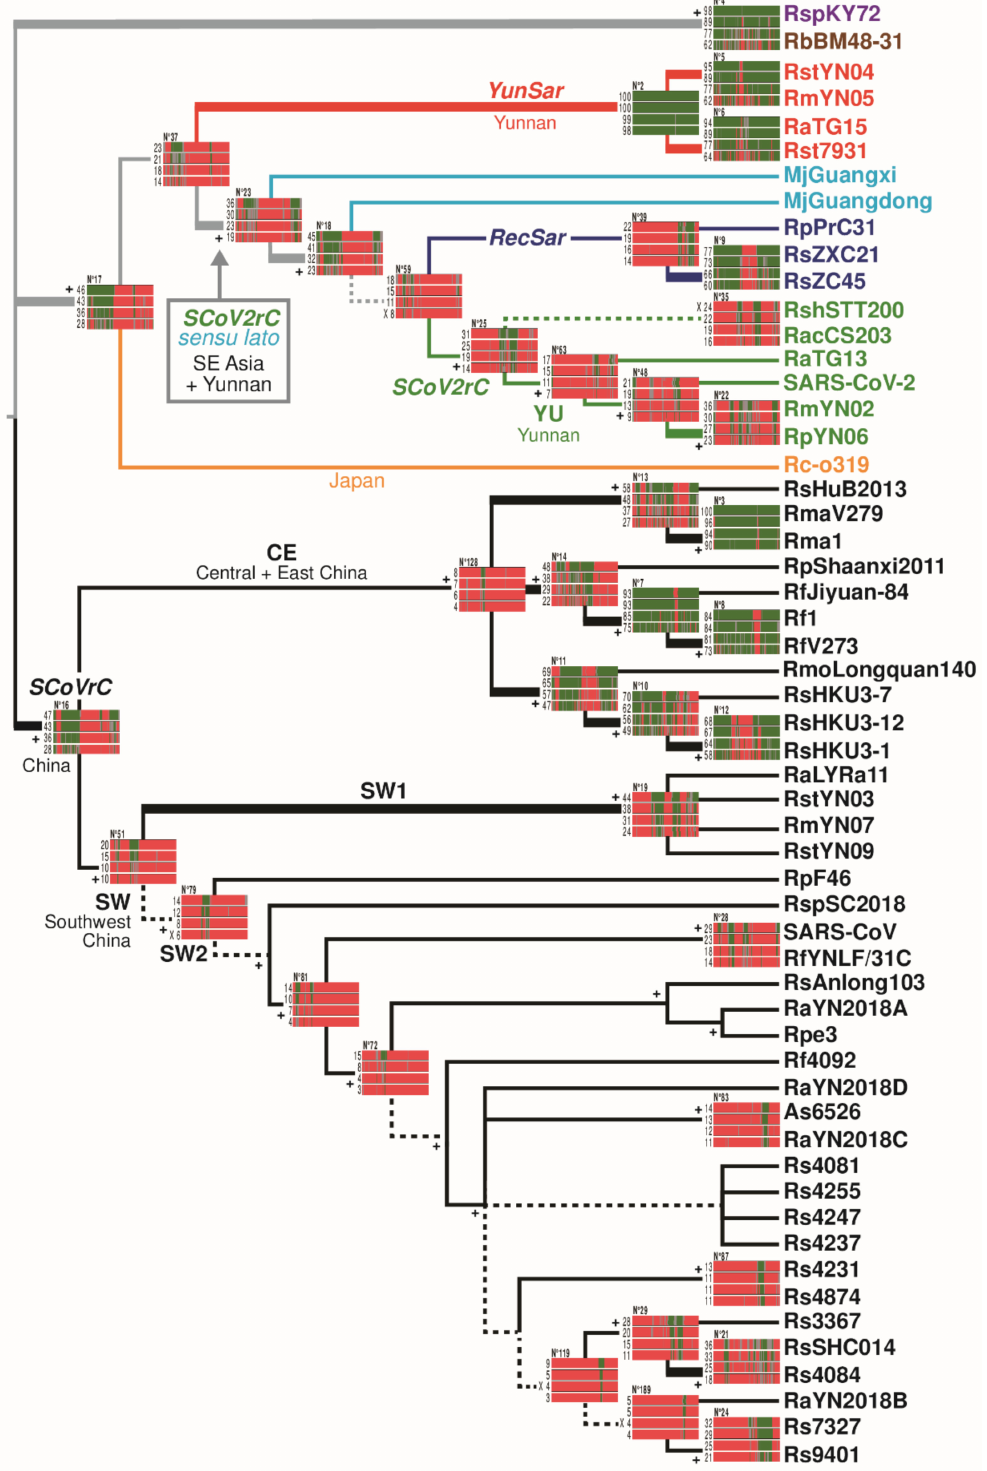
Figure 3. Synthesis tree showing the most reliable relationships reconstructed from SWB analyses of an alignment of 56 Sarbecovirus genomes. Bootstrap analyses were conducted on an alignment of 56 Sarbecovirus genomes (28,845 nt) using the SWB program and four different window sizes (250, 500, 1000, or 2000 nt). Then, the SWB outfiles were tranformed into bootstrap log files using the LFG program. The 572 bootstrap log files generated with a window size of 250 nt were coded by the SuperTRI v57 program [19] into an MRP file, which was then executed in the PAUP version 4.0a [24] to construct a SuperTRI bootstrap 50% majority-rule consensus (SB 250 ) tree using the weighted